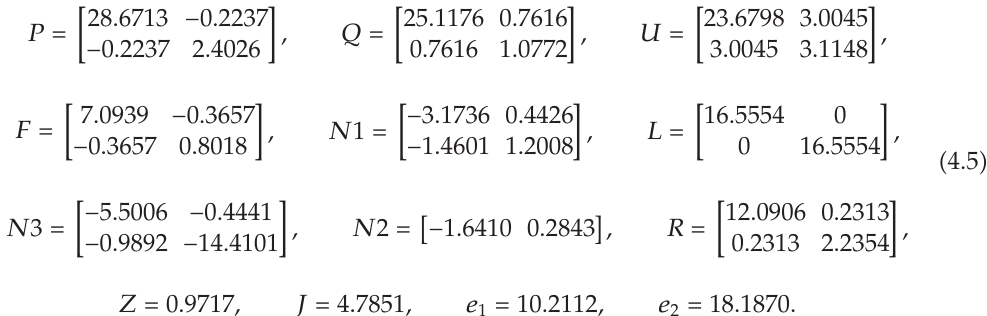
Solution. From the conditions (cid:6) 3.1 (cid:7) of Theorem 3.2, we let α (cid:9) 0 . 4, h 1 (cid:9) 0 . 1, h 2 (cid:9) 0 . 4, t (cid:9) 0 . 8, η (cid:9) 0 . 1, and K (cid:9) 0 . 5. By using the LMI Tool-box in MATLAB, we